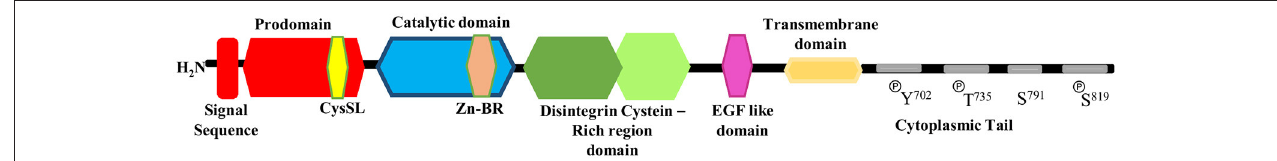
FIGURE 1 | Schematic representation of the structure of full-length ADAM17.